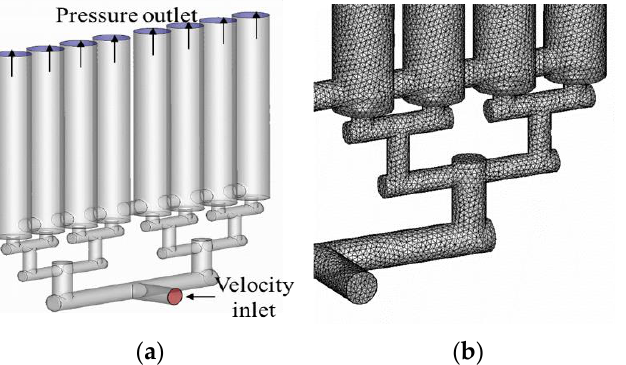
Figure 6. Numerical simulation of the equal inertial pipeline filling–emptying system: ( a ) modeling and ( b ) meshing.